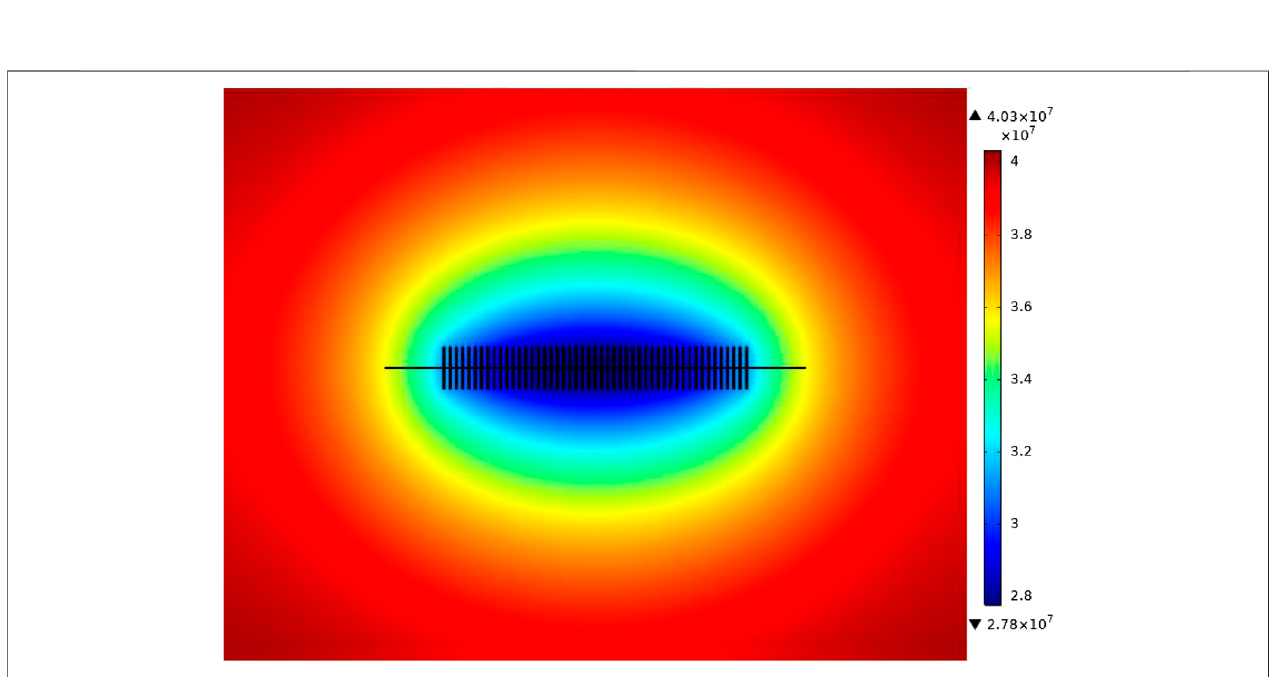
FIGURE 5 | Formation pressure distribution in volume fracturing horizontal well (300 days).